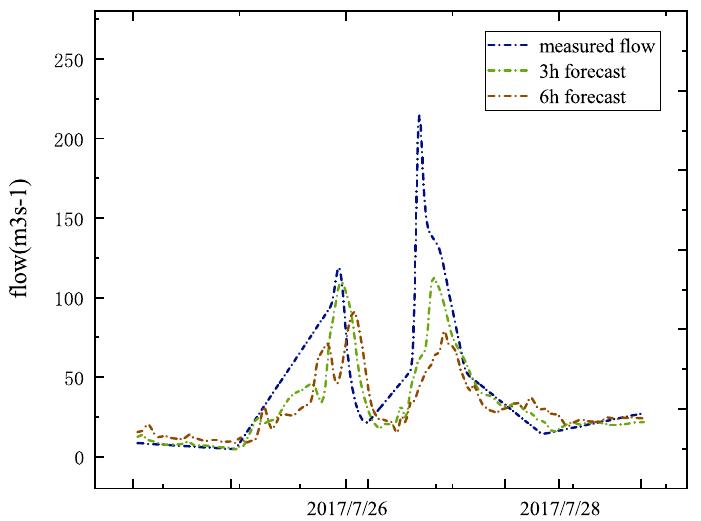
Figure 8. The forecasting process of the No. 20170727 flood. The blue line is the actual measured flow of the Zhaishang site; the green line is the forecast three hours in advance; the brown line is the forecast six hours in